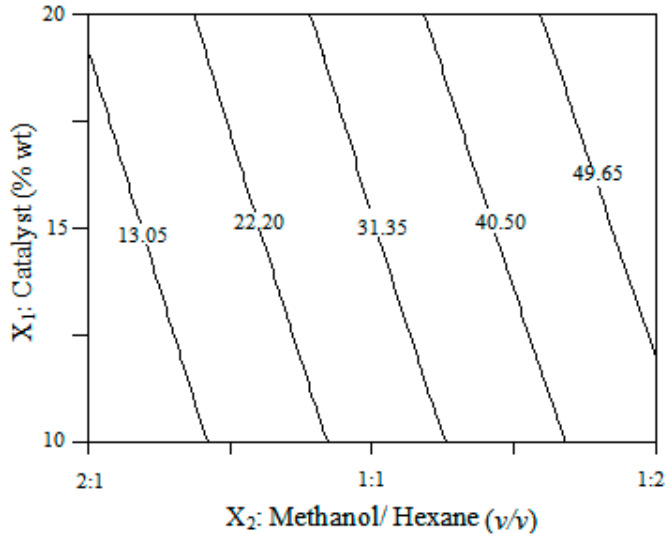
Figure 1. Contour plot for the e ff ect of the catalyst (X 1 , wt) and methanol / hexane (X 2 , v / v ) on the UFAME yield.